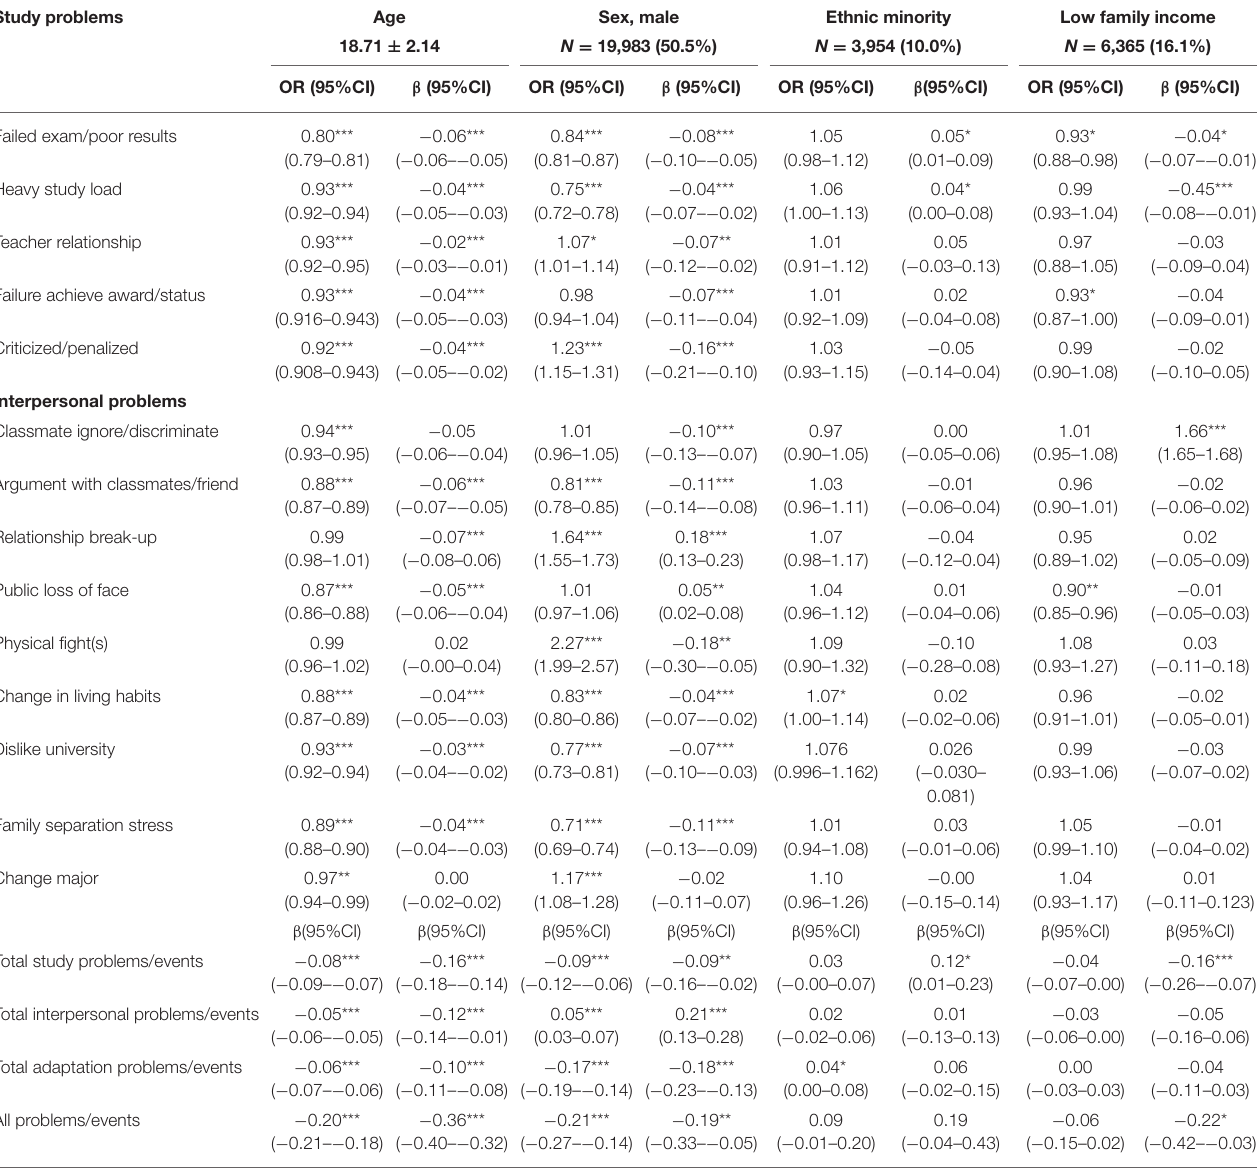
TABLE 1 | Univariate associations between demography and negative ratings associated with adaptation problems to first year undergraduate life ( N = 39,573). Study